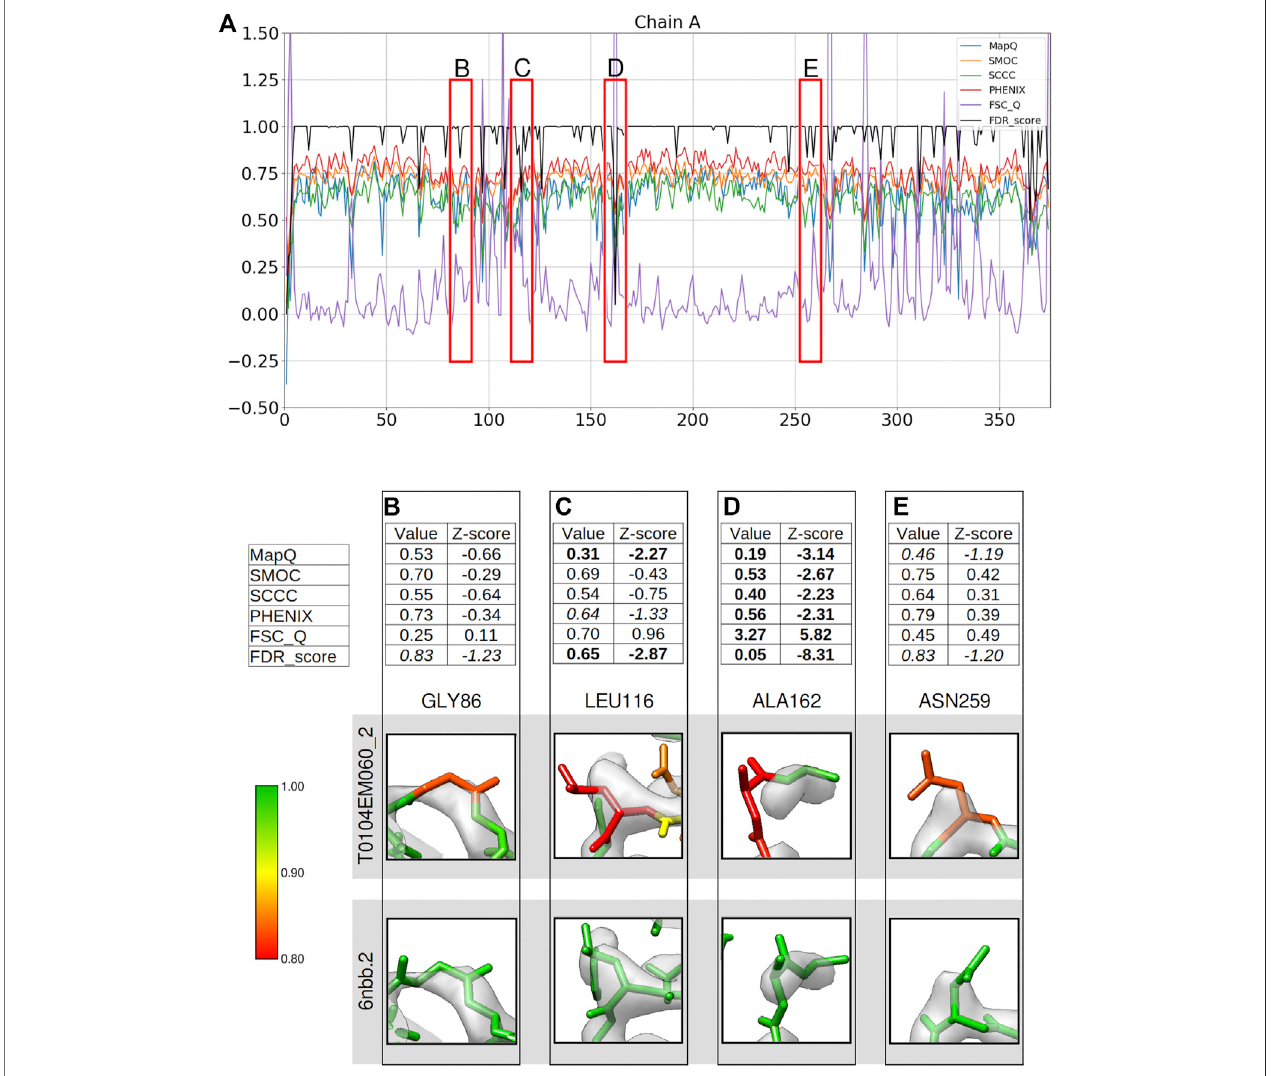
FIGURE 1 | Comparison of local assessment metrics for the atomic model of alcohol dehydrogenase (color bar shows the correspondence with the FDR scores assigned, residues in red have FDR scores around 0.8 or worse, yellow around 0.9, and green around 1.0). The metrics are calculated only for the backbone atoms. (A) Per-residue plot of MapQ, SMOC, SCCC, PHENIX, FSC-Q, and FDR backbone scores for the chain A of the atomic model T0104EM060_2 from the EMDB model challenge,theredboxeshighlighttheresiduesselectedfordetailedanalysisinthepanelsbelow.ForGly86 (B) ,Leu116 (C) ,Ala162 (D), andAsn259 (E) ,thepanel shows a table with values of scores obtained with each metric and corresponding Z-scores; the residue fi t in the target map (EMD-0406, gray) displayed at the recommended contour level and rendered in UCSF Chimera; and the residue fi t in map as modeled in the reference (PDB ID: 6nbb.2).